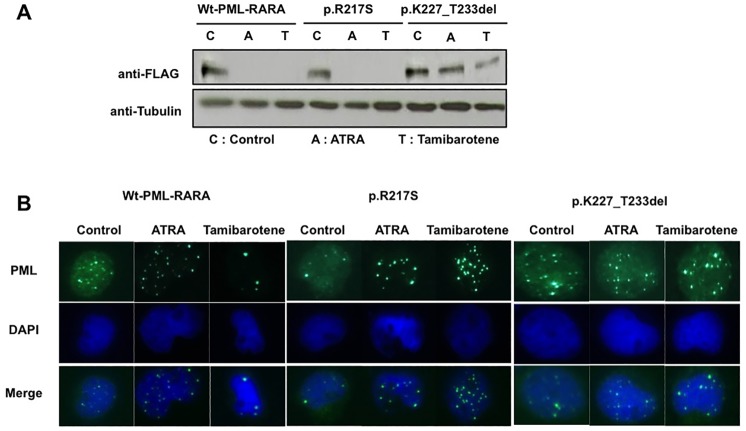
PML-nuclear body formation is impaired in deletion mutant PML-RARA-expressing cells.(A) PML/RARA degradation upon RA treatment in Wt-PML-RARA- and mutant-PML-RARA-transduced cells was analyzed by Western blot using anti-FLAG antibody. The cells were treated with 1 μM of ATRA or tamibarotene for 12 hours. (B) Localization of PML and PML-nuclear body formation was evaluated by immunofluorescence staining in Wt-PML-RARA- and mutated- PML-RARA-transduced HL-60 cells. The cells were treated with 1 μM of ATRA or tamibarotene for seven days.